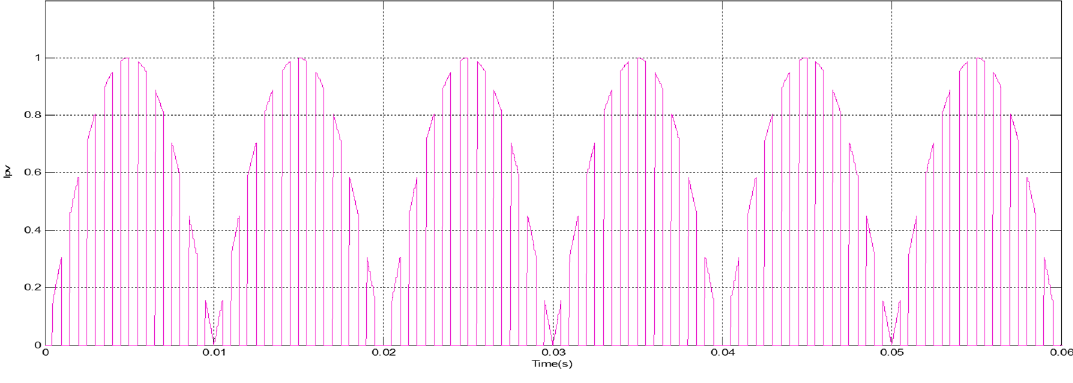
Figure 4. H5 inverter typical.